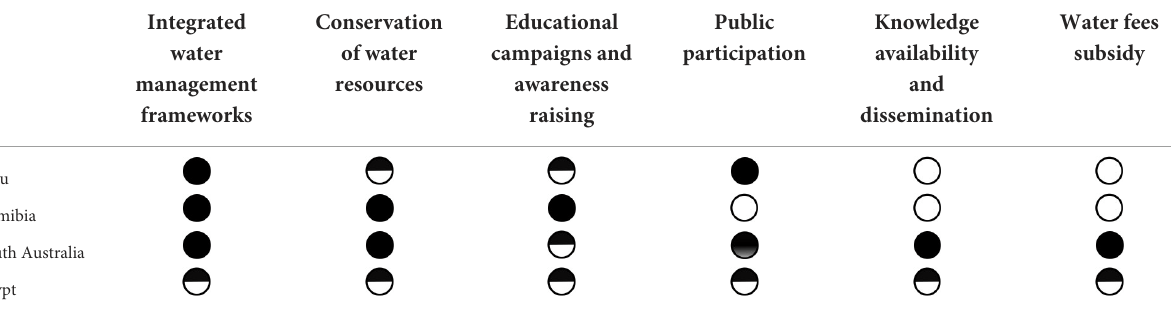
TABLE 1 Water management efforts carried out in the three case studies, classified into six